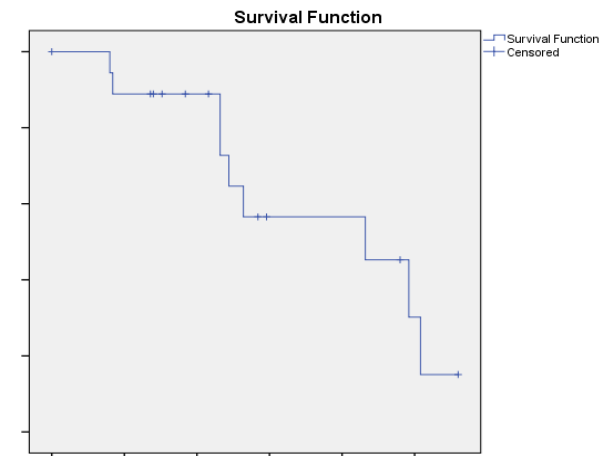
Figure 4. median Progression Free Survival (mPFS) in the papillary RCC patients was 10.8 months (95%CI 4.48 – 17.12).